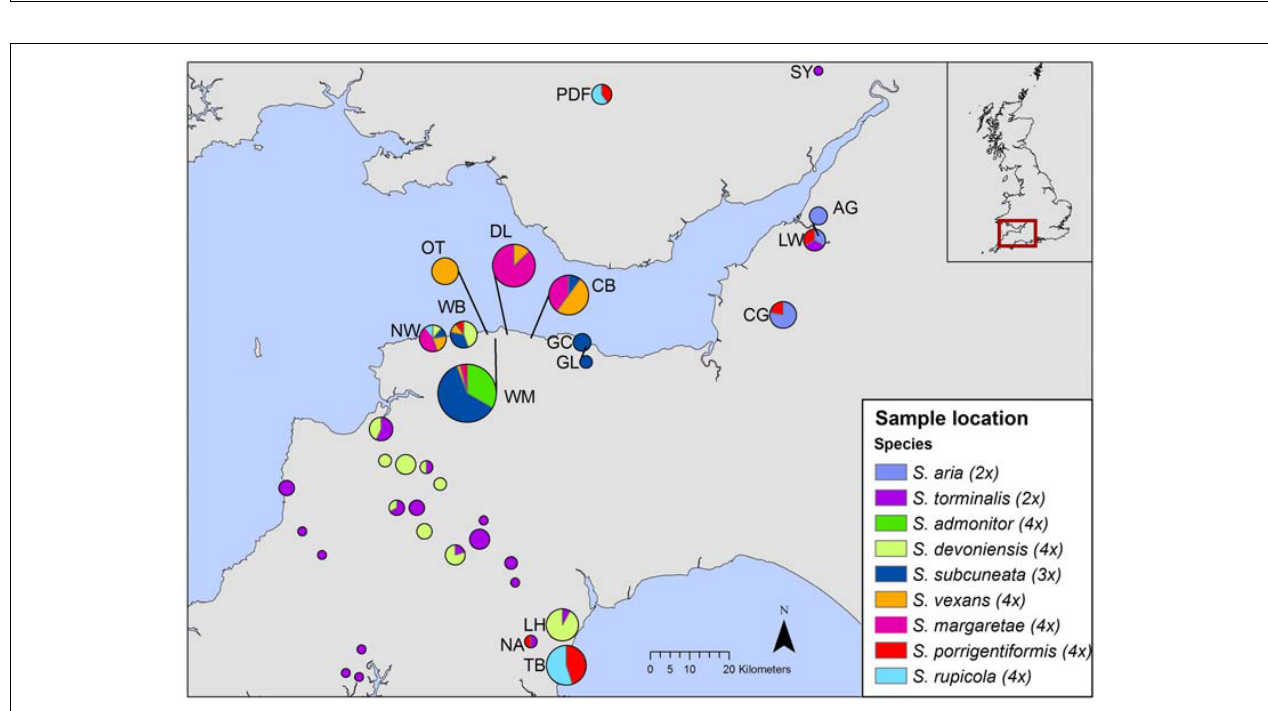
FIGURE 2 | Geographic distribution of samples included in our study. Each pie chart represents a site, with pie size relative to site sample size. The inset shows the area covered by the map. Site codes match those in Supplementary Table S1 (The map was created using ArcGIS Desktop version 10.2.2, ESRI, Redlands, CA, United States, URL: http://www.esri.com/).